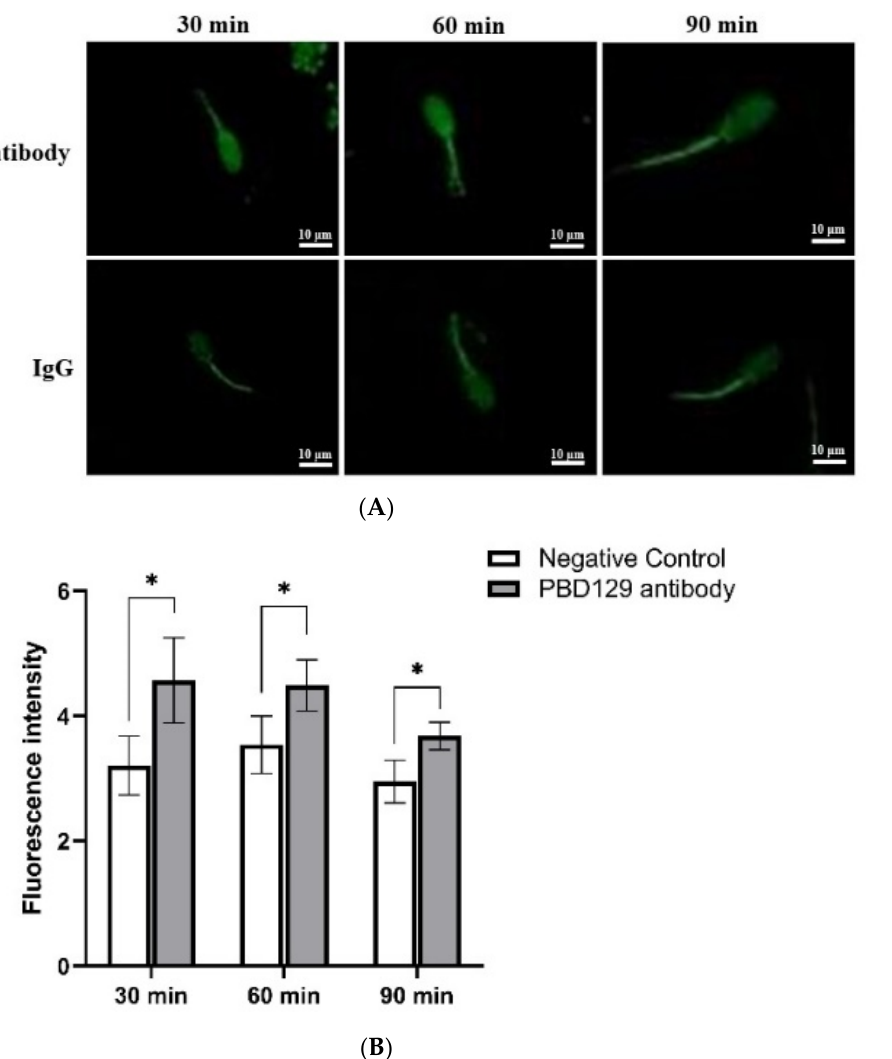
Figure 10. The effect of anti-pBD129 antibody on the influx of Ca 2+ after sperm capacitation in vitro. ( A ) The influx of Ca 2+ is presented as the mean fluorescence intensity of Fluo-3. ( B ) Statistical analysis of mean fluorescence intensity values. The mouse IgG as negative control. Data are presented as the mean± SEM, n = 3. * p < 0.05.